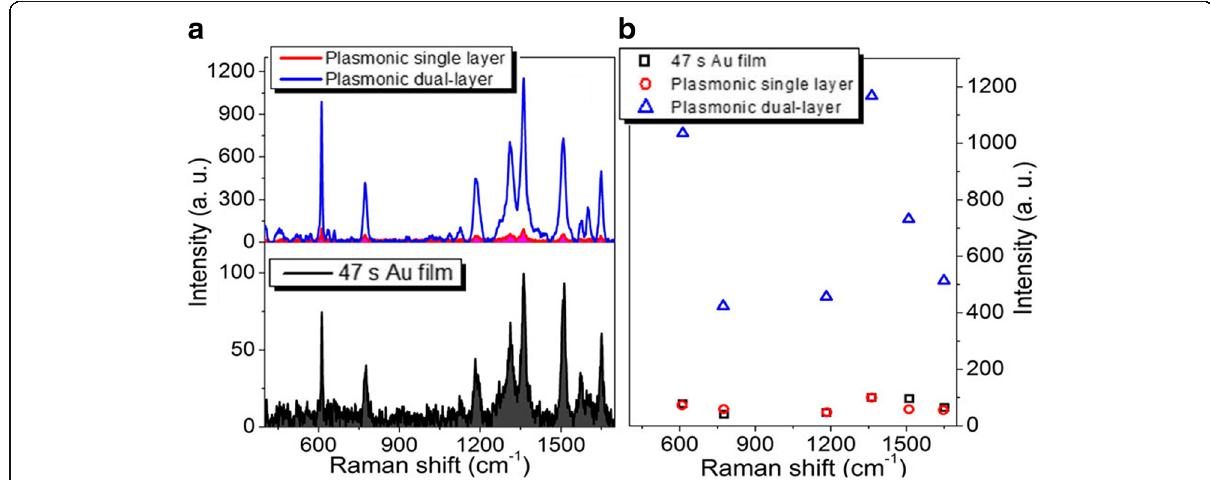
Fig. 6 a Raman spectra of the single-layer and dual-layer porous Au film structures and ultrathin Au film. b Intensity changes of several typical Raman peaks observed in the three Raman curves in a . The sputtering time for each layer of porous Au films and film is 47